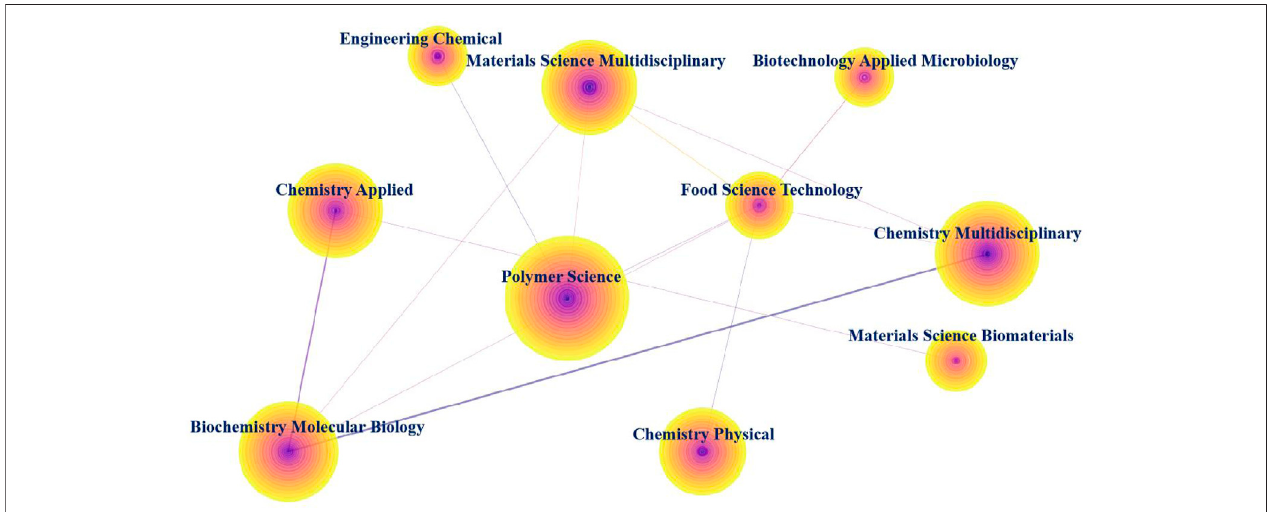
FIGURE 2 | Visualization of the co-occurring subject categories network. (Nodes represent subject categories. The size of a node is proportional to the literature numberofthesubjectcategory.Thelinksrepresenttheco-occurringrelationshipbetweendifferentsubjectcategories.Thecoloroftheringsandlinkscorrespondstothe year. The purple rings indicate high centrality.)